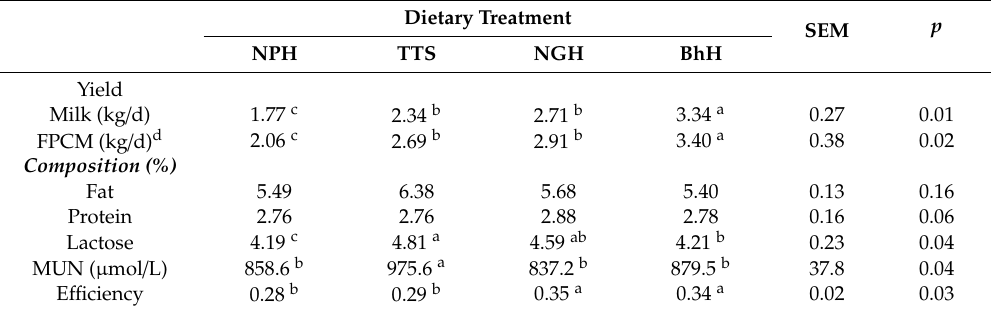
Table 5. Milk yield, composition, and urea content of lactation dairy cows fed natural pasture hay, treated te ff straw, Napier grass hay, and Brachiaria hybrid grass hay. Dietary Treatment SEM